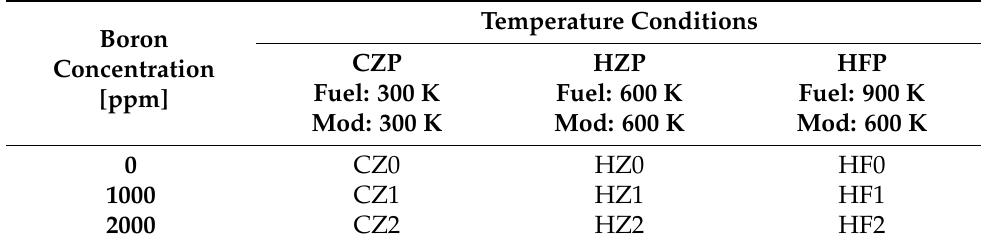
Table 1. Naming Convention for Various Temperature Conditions and Boron Concentrations.